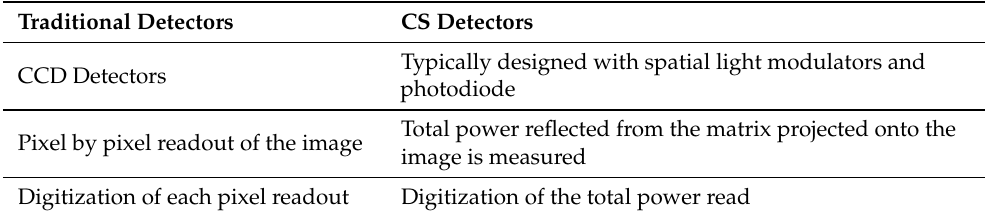
Table 2. Comparison between traditional detectors and CS detectors. Traditional